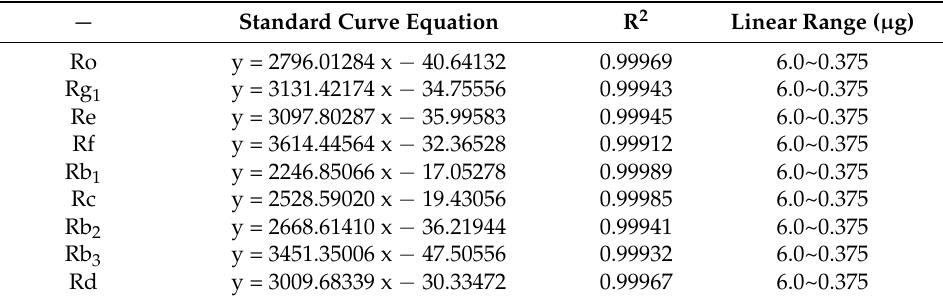
Table 13. Regression equations with correlation coefficients of ginsenoside monomers. − Standard Curve Equation R 2 Linear Range ( µ